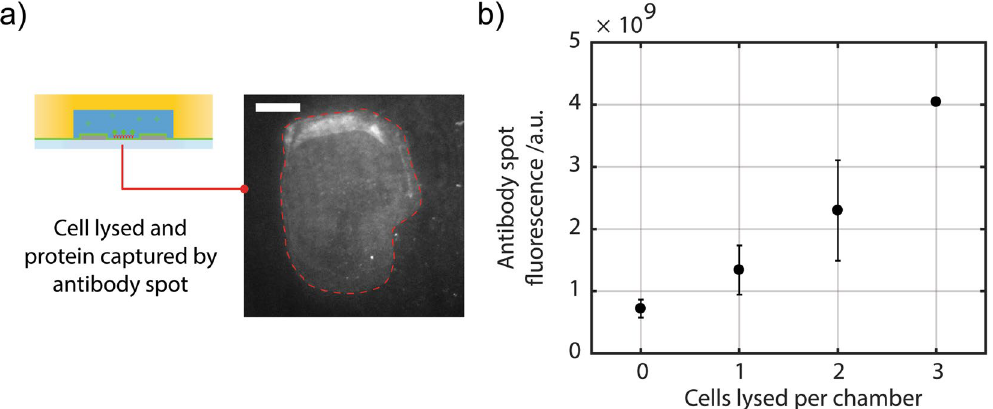
Figure 4. Using microelectrodes in microwells to assay protein from cells. ( a ) The image, acquired by TIRF, shows an anti-GFP antibody spot printed onto a PEI- and microelectrode-coated coverslip and aligned into an individual well of the microwell array. Image shows GFP captured by the antibody spot (within dotted red line). Scale bar length is 25 μ m. ( b ) The number of cells per well follows a Poisson distribution. The antibody spot in each microwell captures fluorescent GFP protein from the electrically lysed cells. The results show that, as expected, the GFP signal increases with increasing GFP-expressing cell